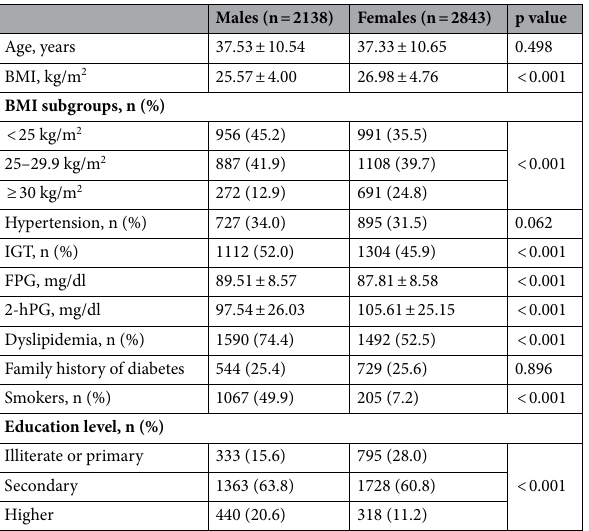
Table 1. Baseline characteristics of the study population. Categorical variables are represented as frequency (percent). Continuous variables are represented as mean ± SD. SBP systolic blood pressure, DBP diastolic median (IQR 25–75).